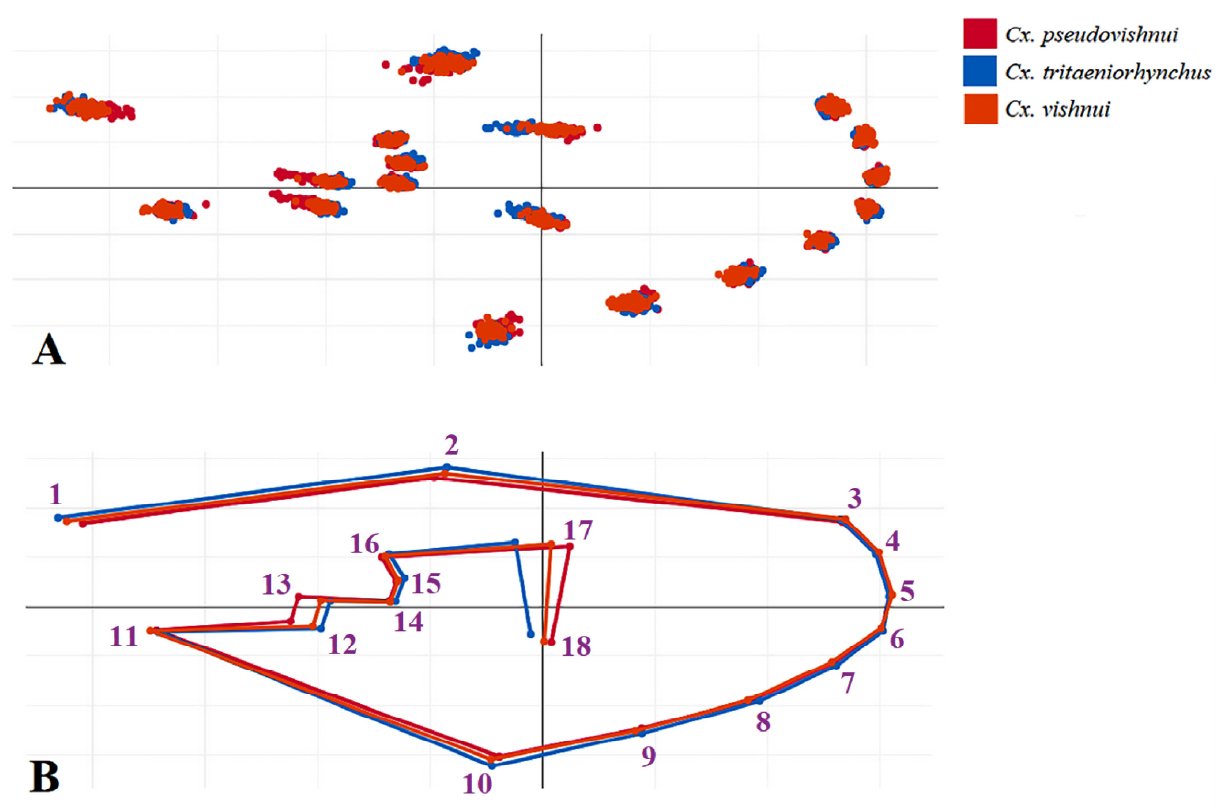
Figure 5. Rotated landmarks of aligned objects ( A ) and the mean landmark superposition ( B ) of Cx. pseudovishnui , Cx. tritaeniorhynchus , and Cx. vishnui wings.